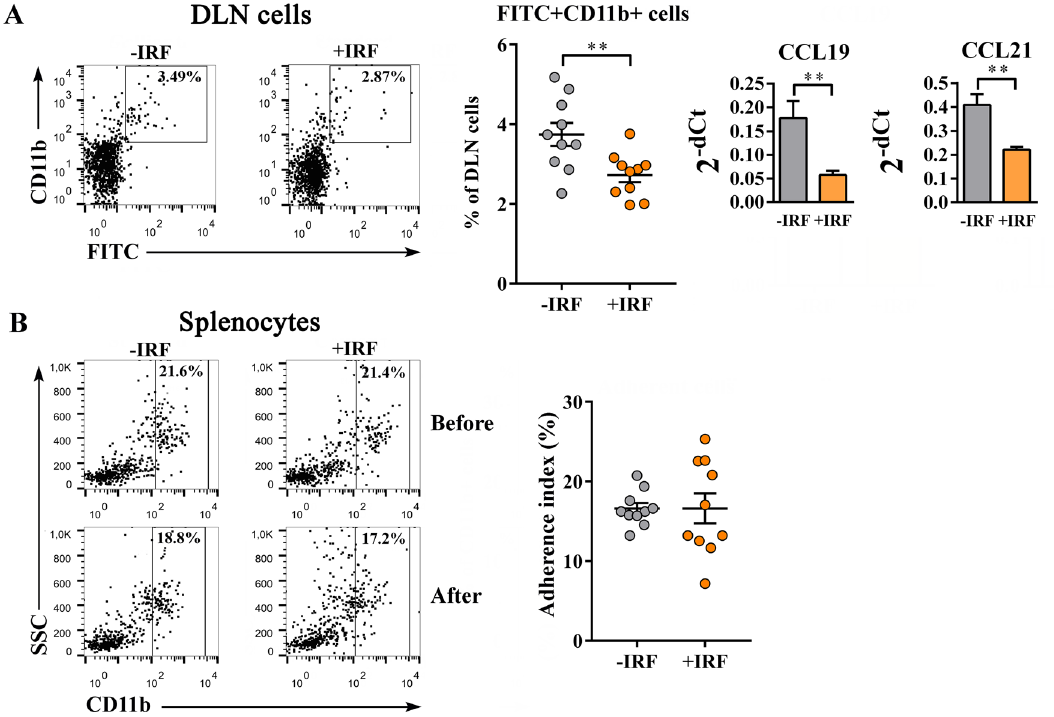
Figure 3. Influence of exposure to IR fibres on the migration and adherence capacity of innate immune CD11b + cells from CIA-affected rats. (A) Representative flow cytometry dot plots show the frequency of FITC- stained CD11b + cells in lymph nodes draining the site of FITC application (DLN) in FITC painting test (see Material and Methods) in CIA rats housed in cages with IR fibre bedding (+IRF rats) and with wooden shaving bedding (−IRF rats). Of note, rats were transferred to cages with IR fibre bedding five days before immunization. Bar graphs show the expression of mRNA for CCL19 and CCL21 in DLNs from +IRF and −IRF rats, as determined by RT-qPCR. Results are represented as 2 −dCt relative to β-actin. (B) Representative flow cytometry dot plots show CD11b expression on splenocytes from +IRF and −IRF rats before (upper dot plots) and after (lower dot plots) passage through nylon wool in the adherence assay (see Material and Methods). Scatter plot indicates the adherence index, i.e. the percentage of adherent cells of CD11b + cells from spleens of +IRF and − IRF rats (calculated as indicated in Material and Methods). (A, B) Flow cytometry profiles were generated using FlowJo Software for Windows, Version 7.8. FlowJo, LLC, Ashland, Oregon, USA (https ://www.flowj o.com). Bar graphs (A) and (B) scatter plot were created using GraphPad Prism version 7.00 for Windows, GraphPad Software, La Jolla California, USA (https ://www.graph pad.com). Results are expressed as mean ± SEM. n = 10 rats/group. ** p ≤